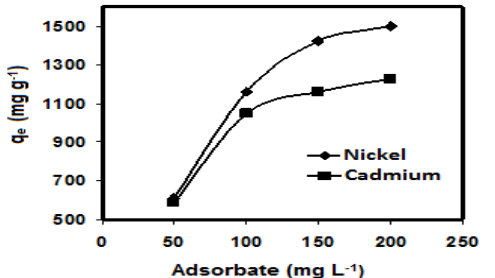
Fig. 6. Effect of initial heavy metal concentration on cadmium and nickel removal by PPI dendrimer (pH=7, C adsorbent =0.08 g/L, T=298 °K)